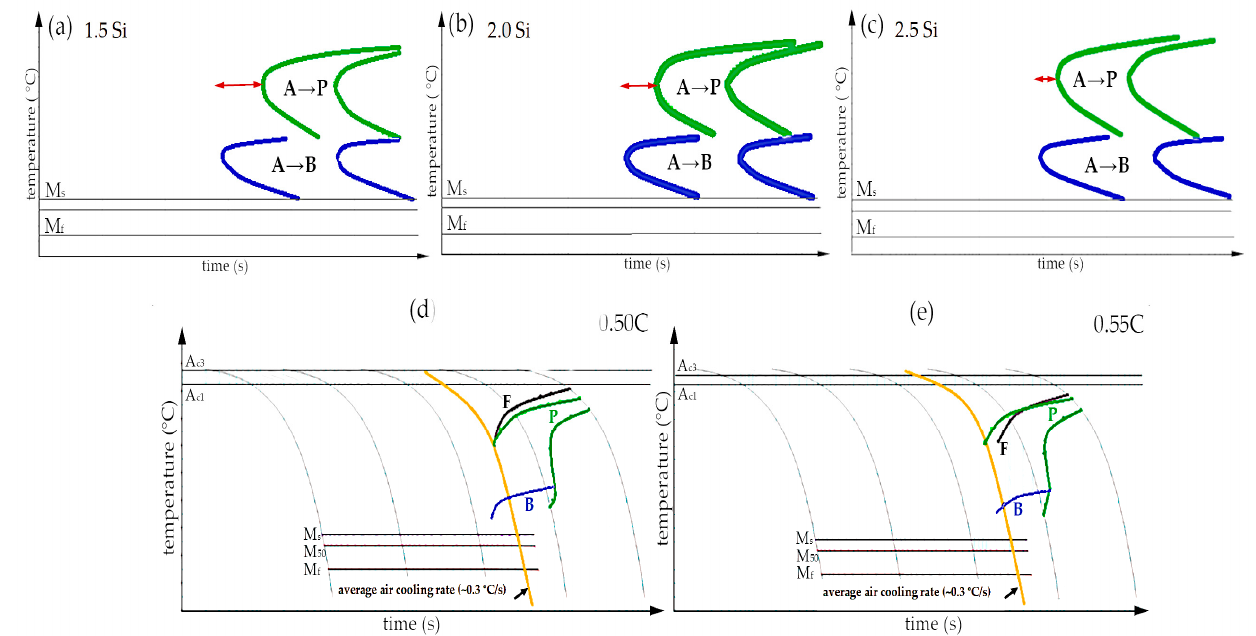
Figure 3. Calculations of phase transformation. The TTT diagrams of Fe-0.45C-XSi-0.5Mn-0.5Mo-0.2V considering: ( a ) 1.5 wt.% Si; ( b ) 2.0 wt.% Si; ( c ) 2.5 wt.% Si. The CCT diagrams of Fe-XC-2.0Si-0.5Mn-0.5Mo-0.2V steel considering: ( d ) 0.5 wt.% C and ( e ) 0.55 wt.% C. JMatPro, version 8.0.